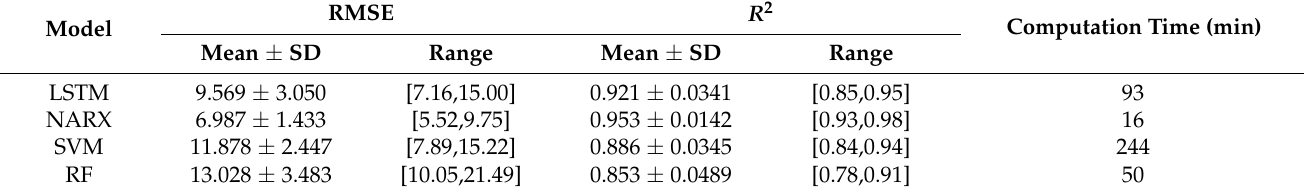
Table 4. Statistics of the evaluation metrics (accuracy and error) for each model based on 10-fold cross-validation.